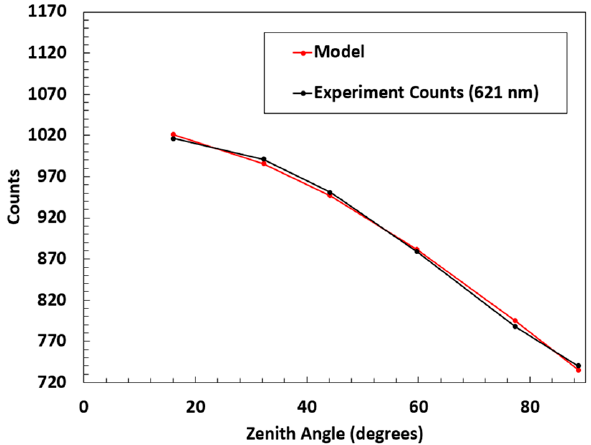
Figure 4. The cosine response of the instrument was measured to ensure proper use as an irradiance detector. Raw counts (no dark counts subtracted) from the spectrometer at 621 nm were recorded while tilting the detector every few degrees. The model curve includes an offset for the dark counts.